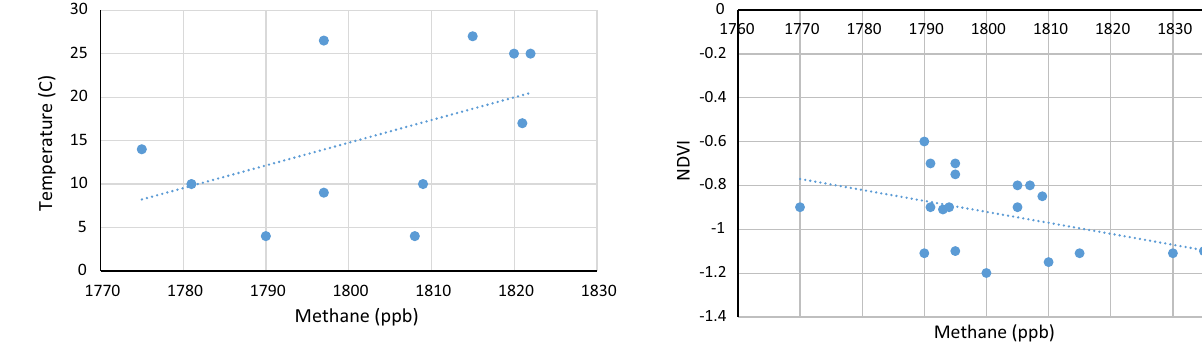
Fig. 3 Relationship between monthly methane and temperature in